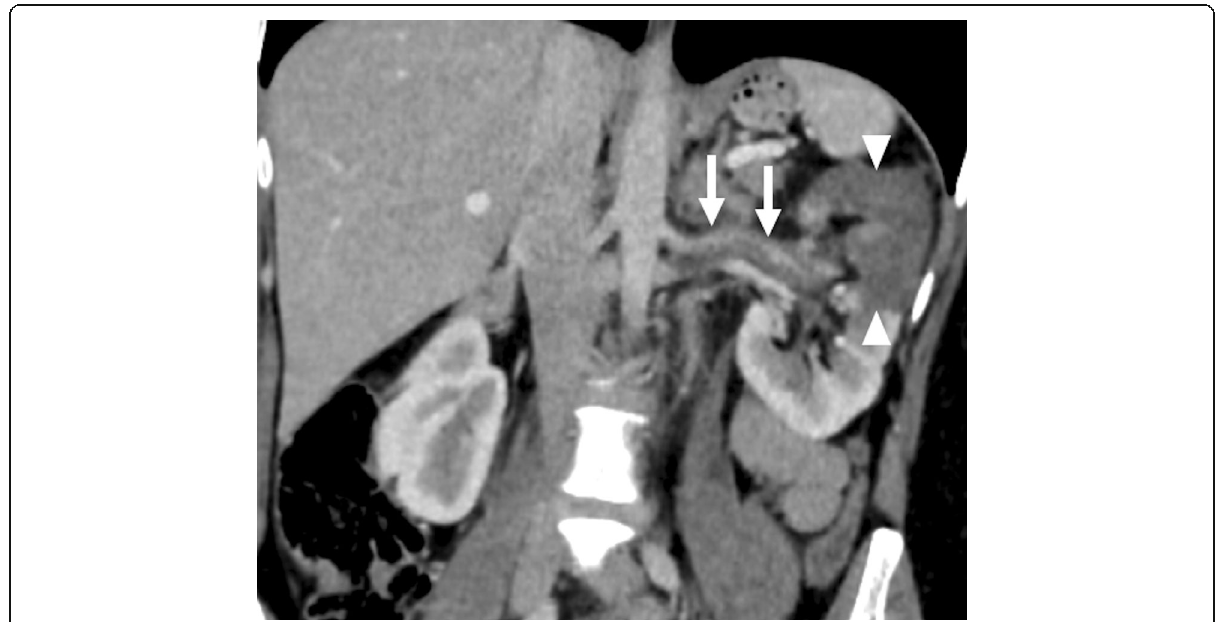
Fig. 11 Renal artery embolism. A 47-year-old female with a history of atrial fibrillation presented with acute left flank pain and massive hematuria. Coronally reformatted post-contrast abdominal CT image demonstrates endoluminal embolus within the left renal artery (arrows). There was also a large parenchymal infarct area (arrowheads) in the upper pole of the left